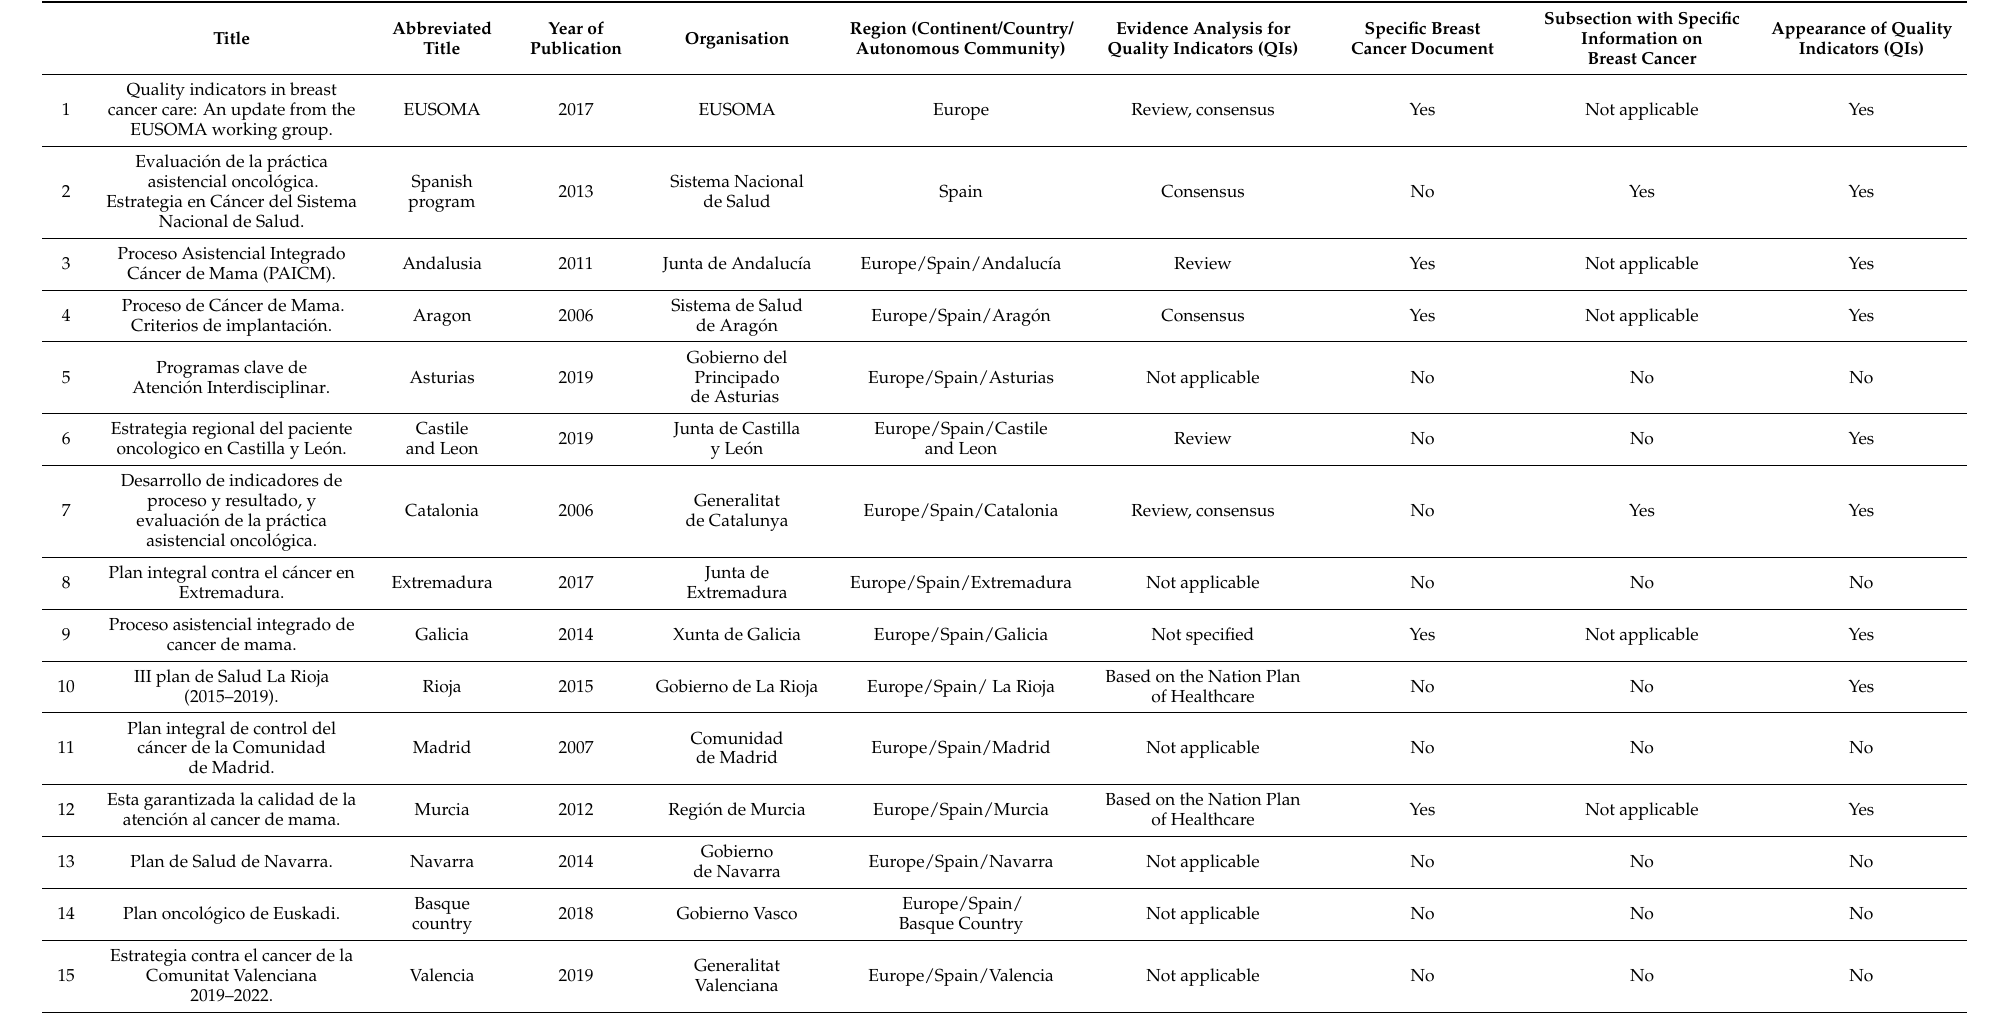
Table 1. Characteristics of the clinical pathways and Spanish integrated BC health care